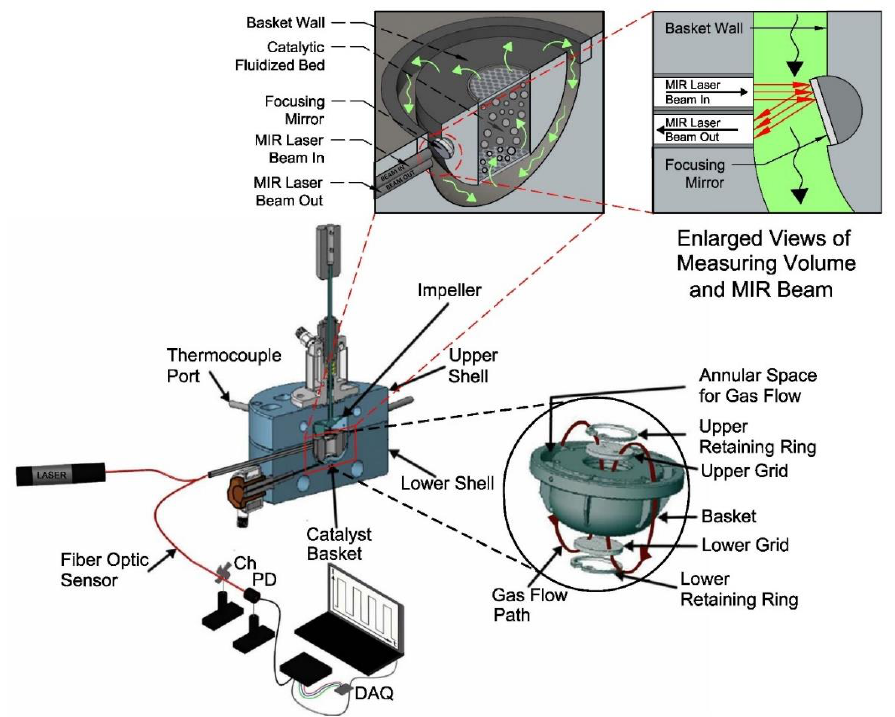
Figure 11. Schematic Illustration of the CREC Riser Simulator Showing the Tools Required to Take Direct MIR Measurements of Chemical Species, Using a Fiber Optic Sensor Placed in the Unit Annular Space, Free of Catalyst Particles. Codes: Ch: Rotating Chopper, PH: Photodetector, DAQ (Data Acquisition Card). Reprinted with permission from Elsevier Ref. [17]. Copyright 2018, Copyright Owner’s Elsevier.